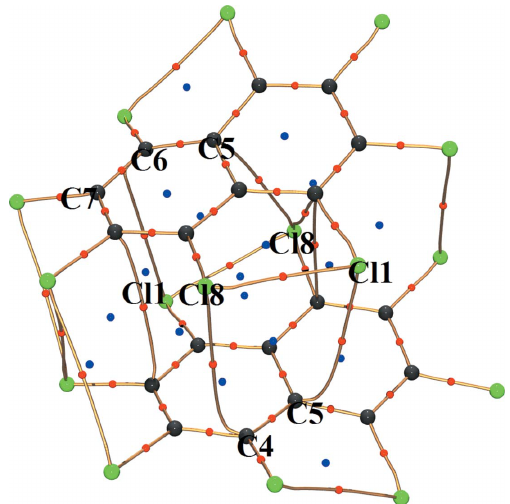
Figure 11 Molecular graph showing various intermolecular interactions between